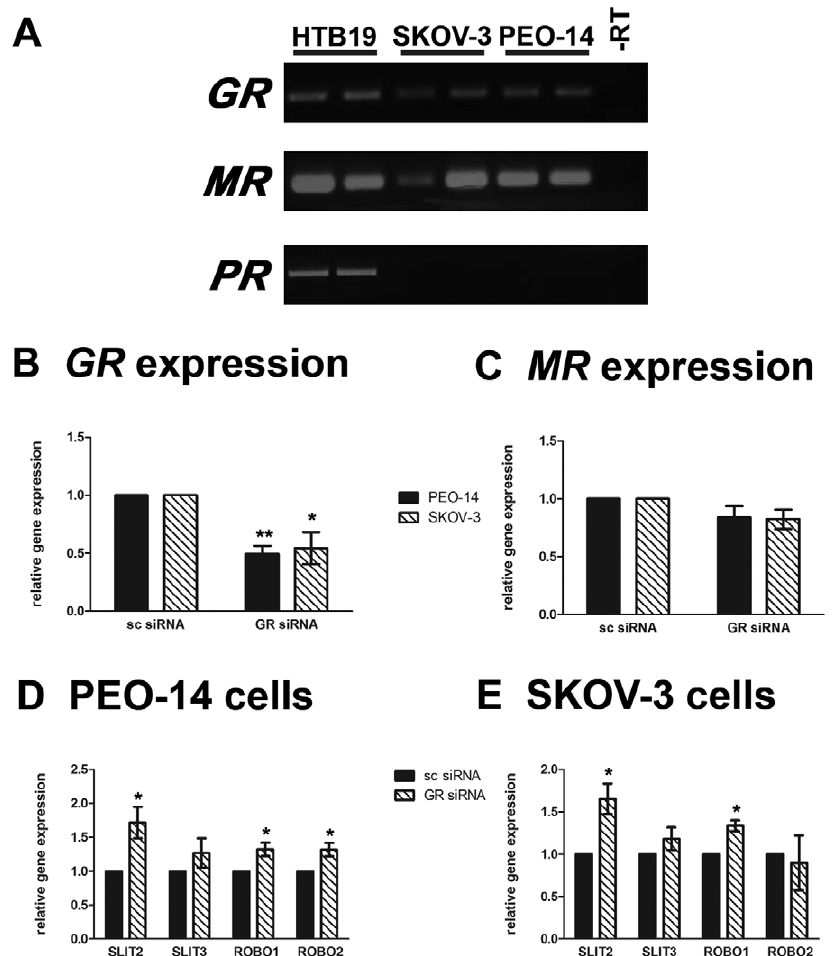
Figure 5. The effect of manipulation of GR on SLITs and ROBOs in ovarian cancer cells. A ) RT-PCR showing that PEO-14 and SKOV-3 cells expressed GR and MR but not PR . The breast tumour cell line HTB-19 was used as a positive control and –RT was used as a negative control. B ) Real- time quantitative PCR demonstrating that transfection with the GR siRNA reduced GR expression in both cell lines when compared to the scrambled (sc) siRNA control. C ) Confirmation that GR siRNA did not affect MR expression in PEO-14 and SKOV-3 cells. D ) Quantitative Real-time PCR showing an increase in SLIT2 , ROBO1 and ROBO2 expression after GR knock down by GR siRNA in PEO-14 cells. E ) Demonstration that GR siRNA transfected SKOV-3 cells also had increased SLIT2 and ROBO1 expression. *= P ,